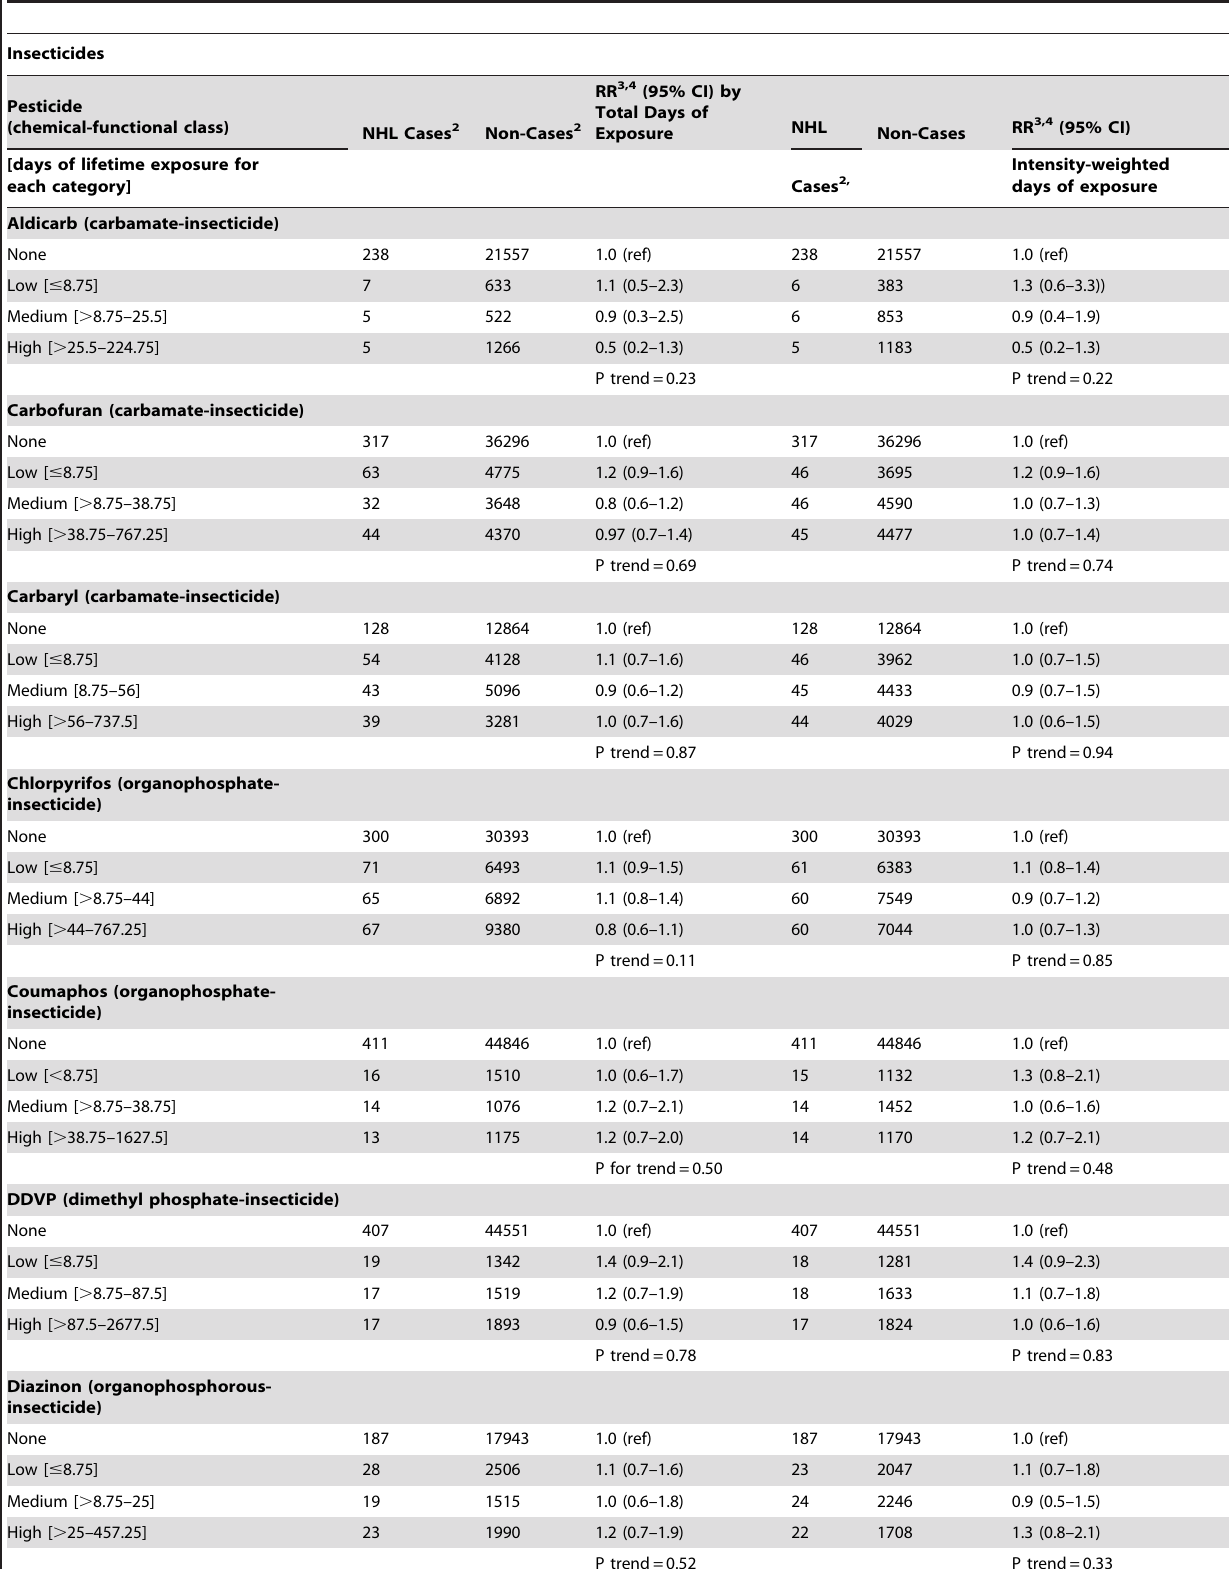
Table 3. Pesticide exposure (lifetime-days & intensity weighted life-time days) and adjusted risks of total NHL incidence 1 .